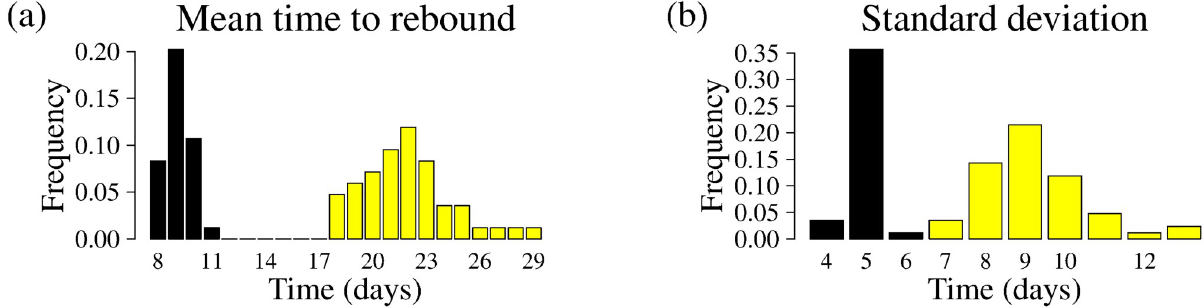
Fig 7. Model-predicted mean and standard deviation in time to viral rebound across the study population. Histograms show the (a) mean and (b) standard deviation in time to viral rebound across ATI study population (see Description of data ). Black/yellow indicates absence/presence of NNRTIs in the pre-ATI ART